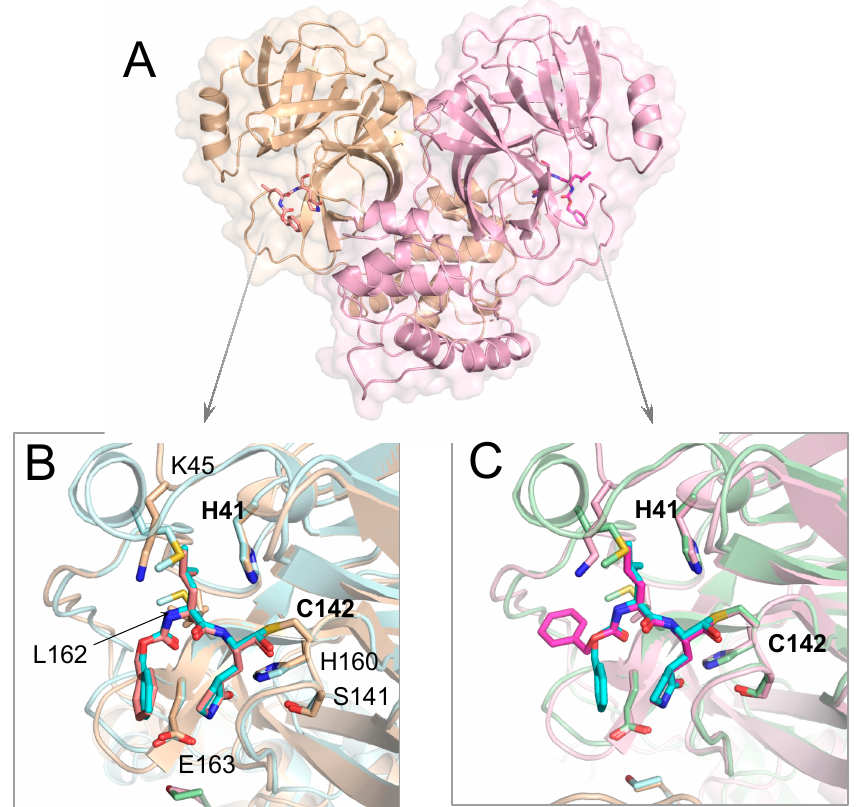
Figure 1. Crystal structure of M pro from gamma-CoV SW1 bound to inhibitor GC376. ( A ) The overall structure is displayed above in cartoon representation with a transparent surface and the two protomers colored pink and wheat. The inhibitor molecules covalently bound at the active sites are magenta and in stick representation. ( B , C ) The close-up views of the two active sites, where the SARS-CoV-2 M pro structure (PDB 6WTJ) is superimposed and depicted in light blue and green cartoon representation. The key active site residues interacting with the inhibitor are labeled in ( B ). The terminal benzyl group of the inhibitor is flipped relative to the canonical binding mode (as seen in SARS-CoV-2 M pro ; teal sticks) in one of the protomers ( C ).